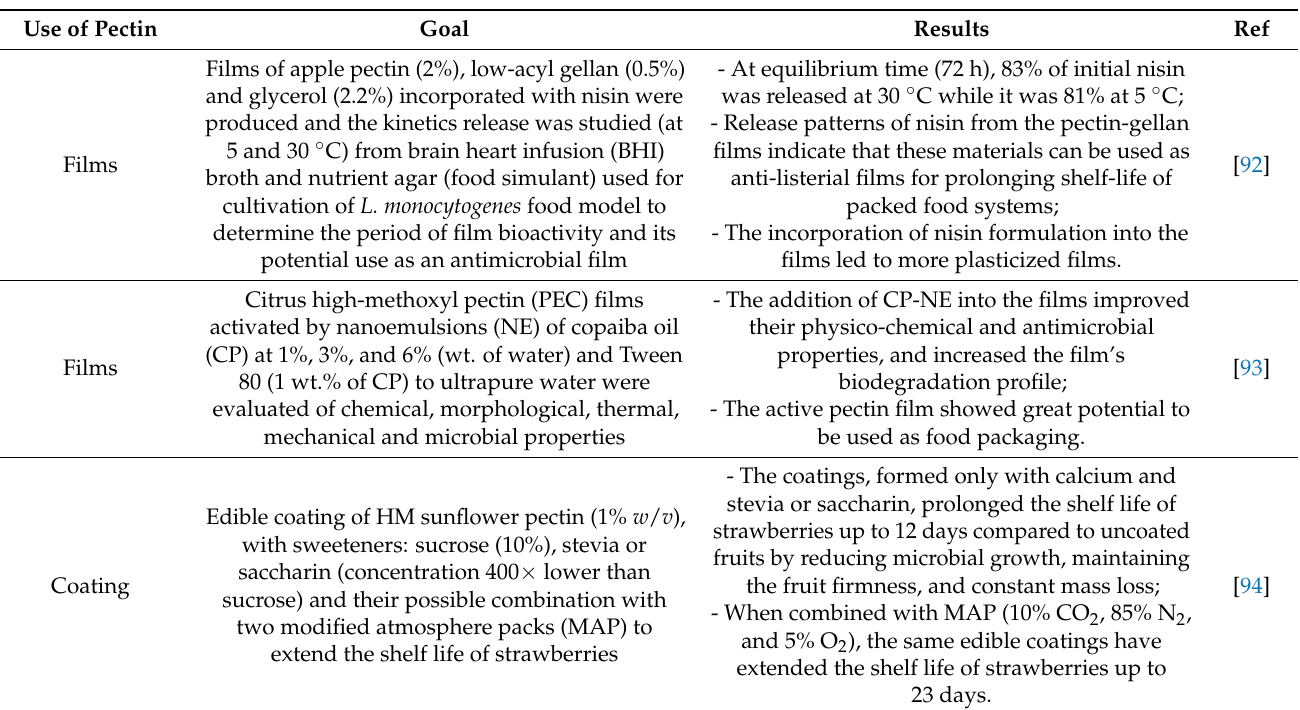
Table 3. Studies using pectin as an edible coatings and food